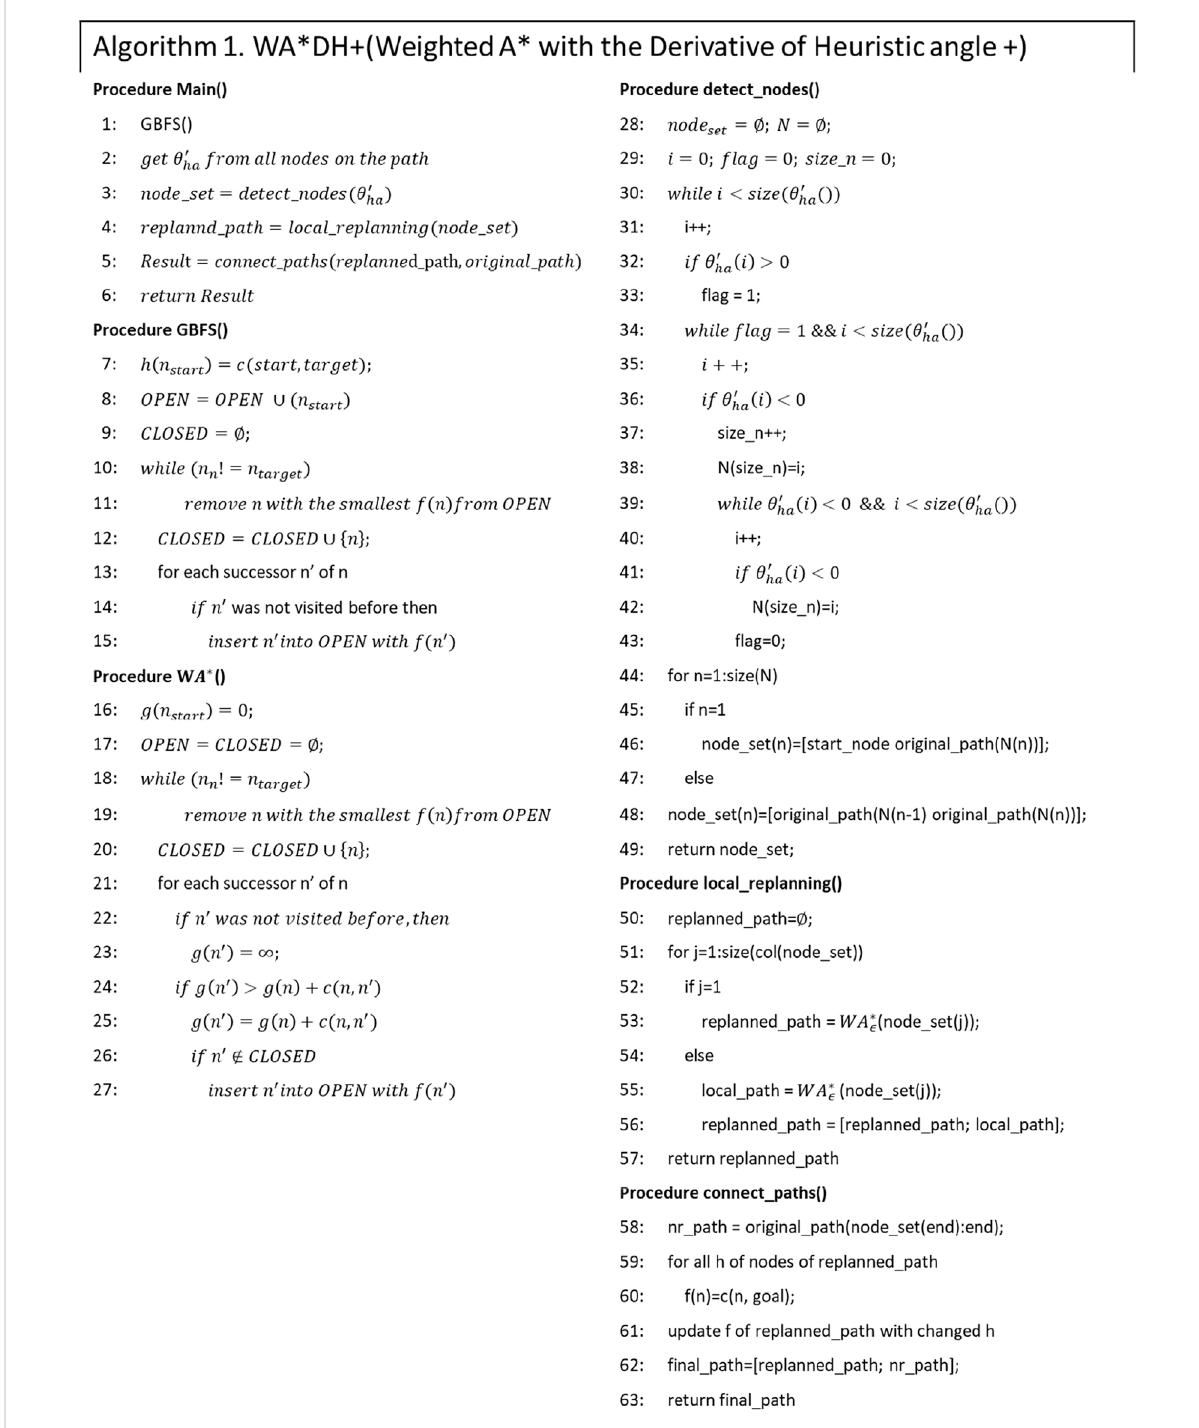
FIGURE 9 Pseudocode of